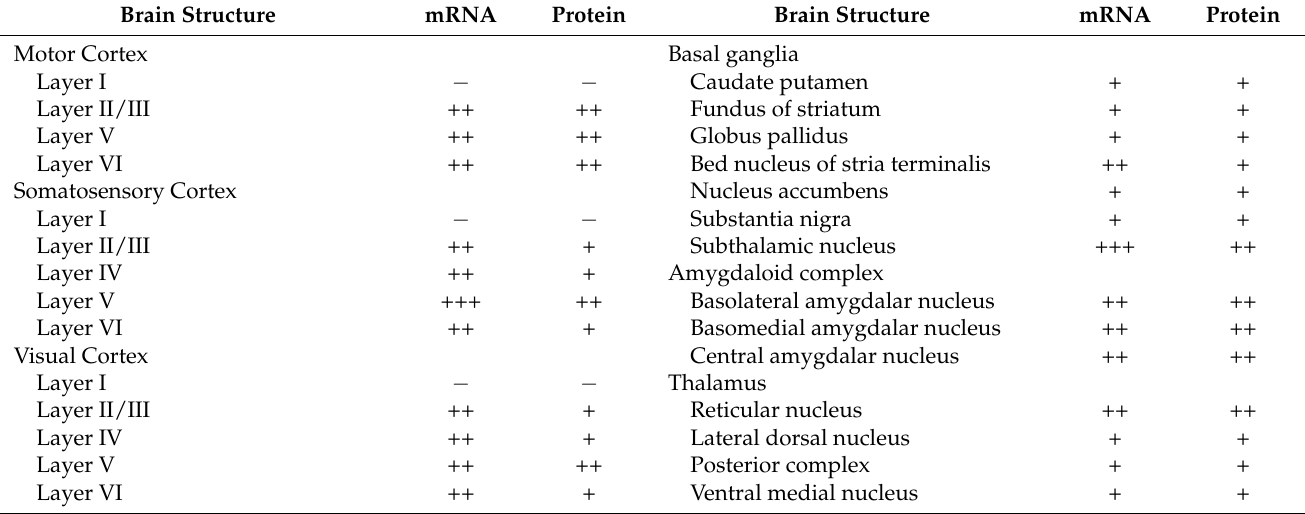
Table 1. VPS13A expression in the mouse